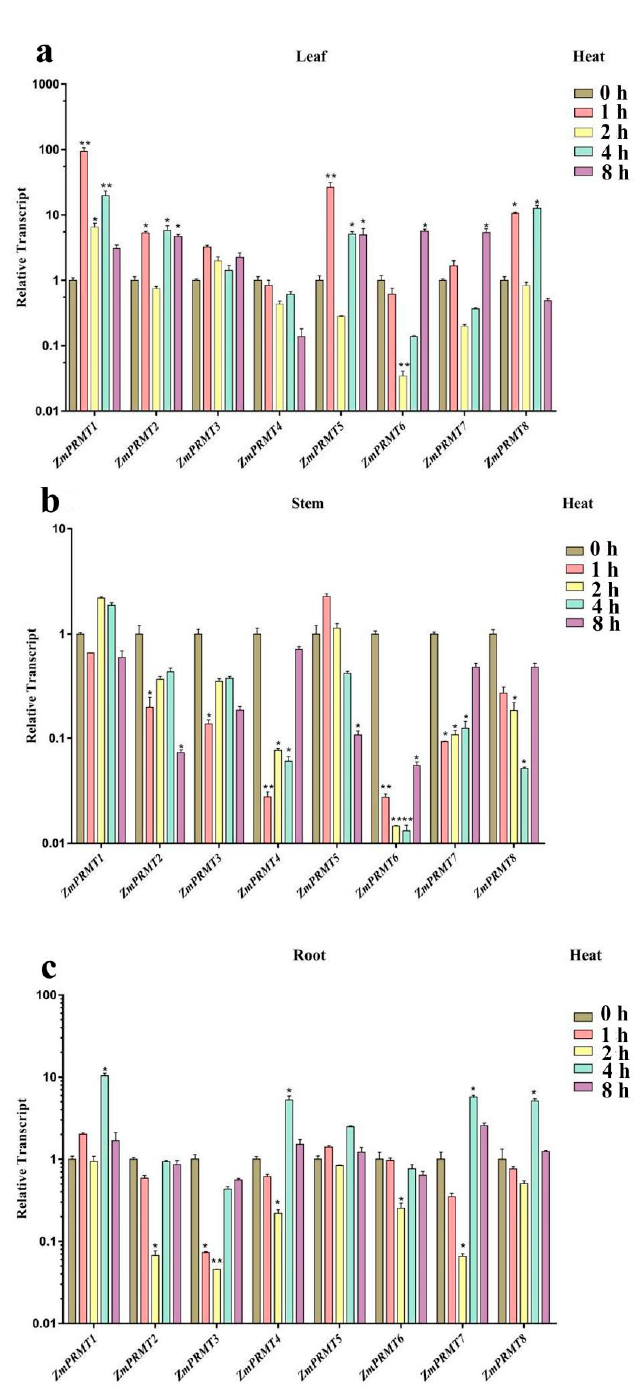
Figure 5. Expression profiling of the 8 ZmPRMT genes exposed to heat stress treatment in maize tissues (roots, stems and leaves). ( a ) The expression profiling of the 8 ZmPRMT genes exposed to heat stress treatment in maize leaves. ( b ) The expression profiling of the 8 ZmPRMT genes exposed to heat stress treatment in maize stems. ( c ) The expression profiling of the 8 ZmPRMT genes exposed to heat stress treatment in maize roots. The qRT-PCR data was standardized with the maize ZmActin1 gene. The control condition was represented as CK (0 h), and the heat stress conditions were represented as Heat (1 h, 2 h, 4 h and 8 h). X-axes represent the genes under different treatments, while y-axes represent the scale of the relative expression level of genes. Error bar is generated by three biological repetitions. The significance level is indicated by the asterisk at the top of the error bar. p < 0.05 is significantly different *; p < 0.01 is significantly different